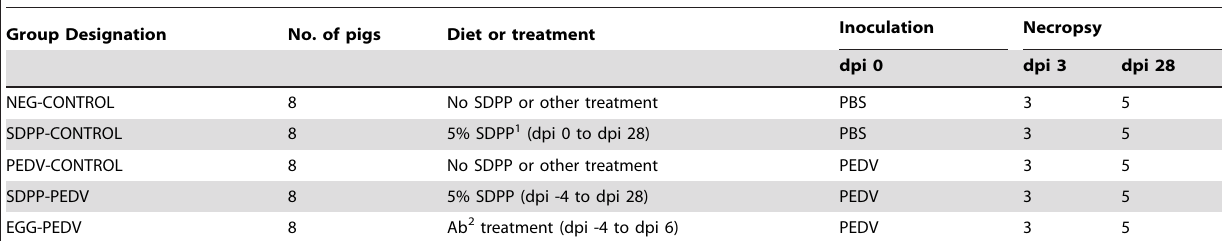
Table 1. Experimental